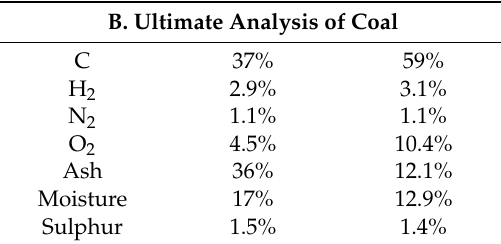
Table 5. Ultimate analysis data.